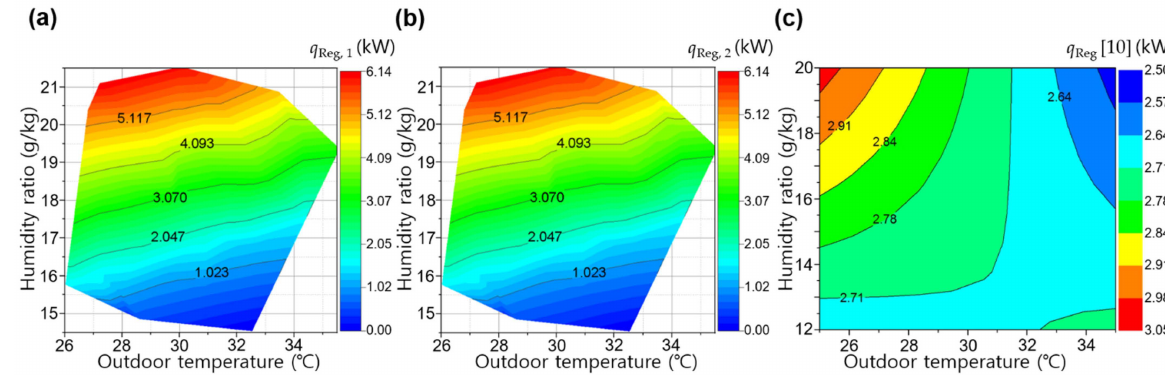
Figure 9. Regeneration heat of ( a ) Unit 1 and ( b ) Unit 2. ( c ) Field test data [10] of regeneration heat for the existing